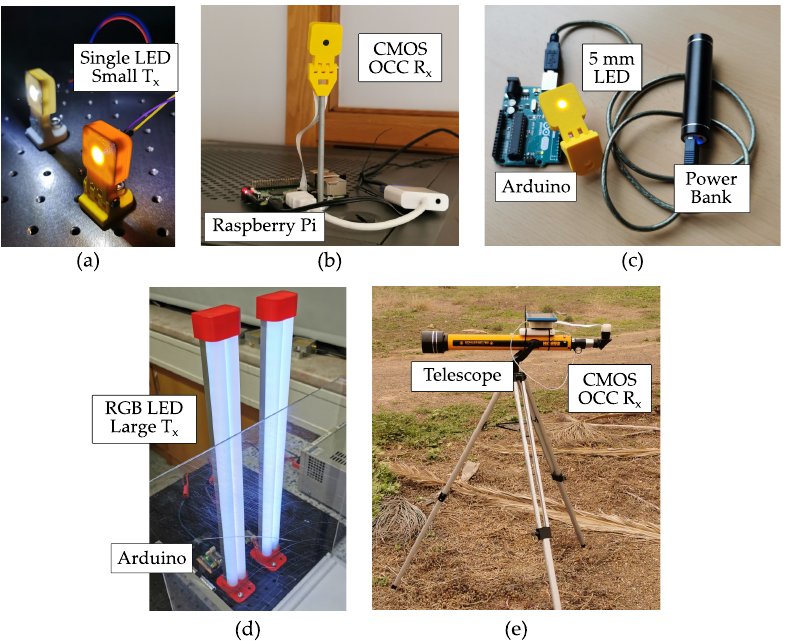
Figure 4. Hardware and equipment developed for the OCC experiments. ( a ) Single LED small transmitters. ( b ) CMOS camera-based OCC receiver. ( c ) Standalone implementation of the single LED small transmitters. ( d ) RGB LED large transmitters. ( e ) Large optics (telescope) CMOS-based receiver.